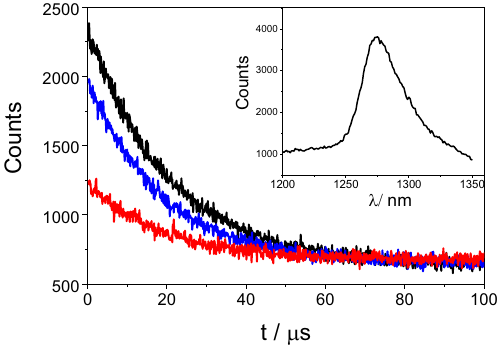
Figure 11. Decay curves of the singlet oxygen generated by free TPPNH 2 (black), GO-CONHTPP (blue) and a non-covalent mixture of TPPNH 2 and GO (red) in DMF (λ exc = 408 nm, λ mon = 1270 nm, collection time: 10 min). Inset: phosphorescence spectrum of 1 O 2 measured for TPPNH 2 in DMF.